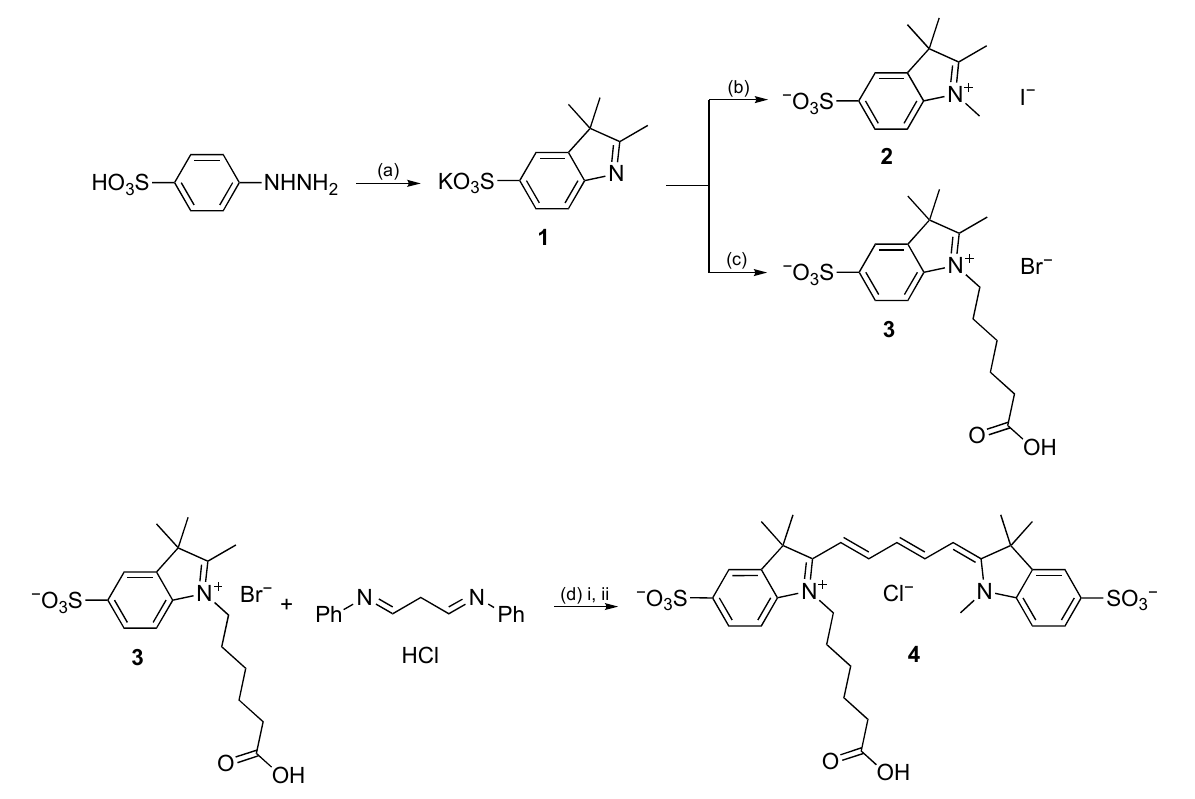
Table 1. UV-vis absorption and fluorescence data of sulfo-Cy5 carboxylic acid 4 (1 × 10 − 6 M) at pH 7.4 in PBS.